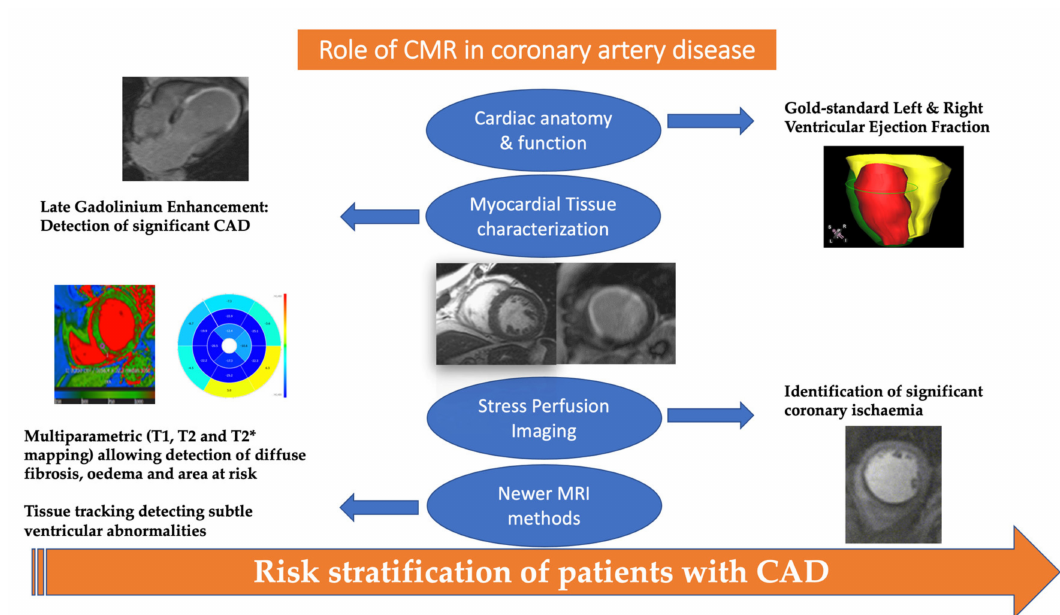
Figure 1. Role of cardiac magnetic resonance in the management of patients with suspected or known coronary artery disease. T2* can be considered an observed T2, whereas the T2 can be considered the natural T2 of the tissue being